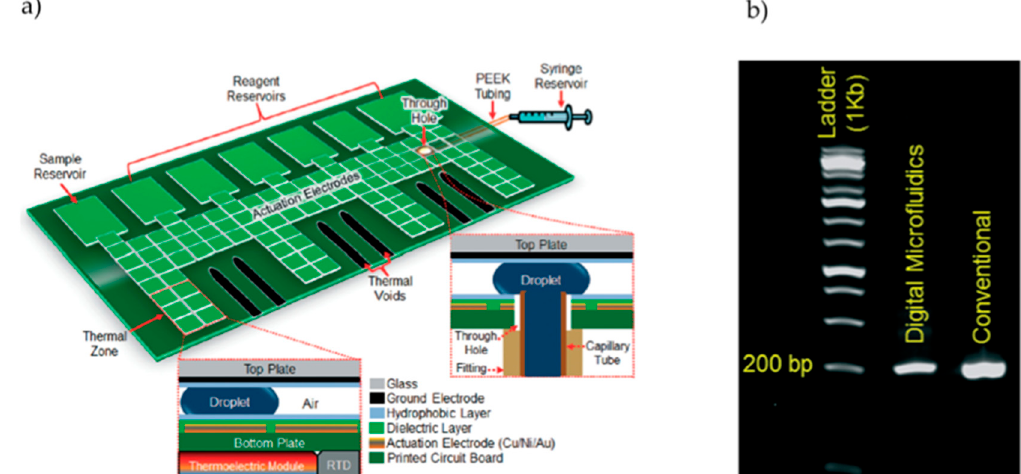
Figure 3. Two-plate air-matrix DMF platform. ( a ) Air-filled DMF platform, featuring a droplet refill system. The primary regions of the device are highlighted, such as actuation electrodes and reagent reservoirs, heating areas (temperature control relies on thermoelectric modules and resistive temperature detectors placed under the printed circuit boards (PCB) substrate) and platform-refill system connections. ( b ) Electrophoretic analysis of on-chip versus off-chip PCR products for M13mp18 bacteriophage DNA, in comparison with a DNA ladder. Adapted from original in reference [22].